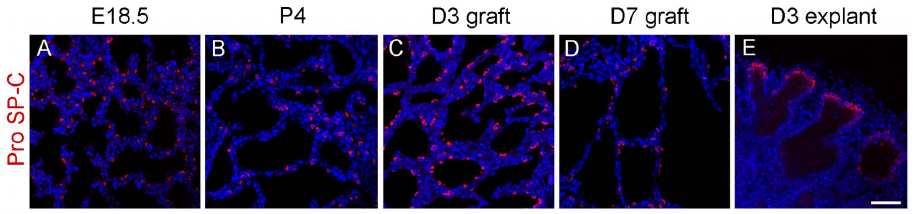
Figure 3. Differentiation of AEC-II cells in lung allografts. E15.5 WT lungs were diced and implanted underneath the renal capsule. Sections of fetal lung tissues, allografts and explants at indicated time points were immunostained with pro SP-C antibody. (A) E18.5 lung tissue, (B) P4 lung tissue, (C) day 3 allograft, (D) day 7 allograft, (E) day 3 explant. Pro SP-C-positive AEC-II cells were found scattered in saccular structures of fetal lung tissues and renal capsule allografts (A–D), while, pro SP-C-positive AEC-II cells were found lining the distal acinar tubules in lung explants (E). Red color: pro SP-C; blue color: DAPI. Scale bar, 50 m m.